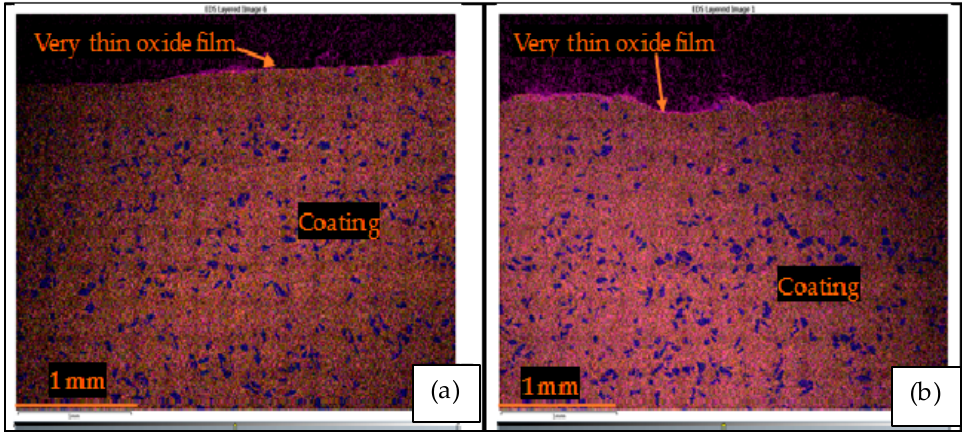
Figure 9. T-800/WC oxide film thickness at ( a ) t > 24 h and ( b ) t = 120 h.